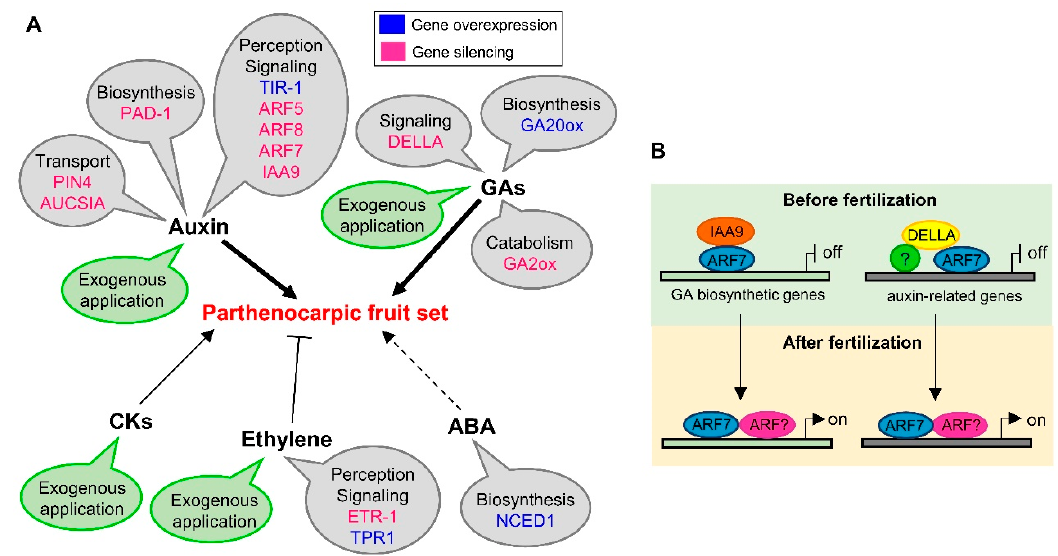
Figure 2. Schematic model of hormonal regulation of parthenocarpic fruit set in tomato ( A ) Parthenocarpy obtained either by exogenous treatments or by genetic manipulations of phytohormones. Gene name in blue means that the gene overexpression leads to parthenocarpy; gene name in pink indicates that the gene silencing causes parthenocarpy. TIR ‐ 1 (TRANSPORT INHIBITOR RESPONSE 1), auxin receptor; ARF5/7/8 (Auxin Response Factor 5/7/8) components of the auxin signaling pathway; PAD ‐ 1 (aminotransferase) implicated in auxin biosynthesis; PIN4 (PIN ‐ formed 4 auxin efflux carrier), component of the auxin transport; AUCSIA (AUxin Cum Silencing Action), probably implicated in the regulation of auxin transport; DELLA, repressors of GA responses; GA20ox (GA 20 oxidase) a GA biosynthetic gene; GA2ox (GA 2 oxidase), a GA catabolic enzyme; NCED (nine ‐ cis ‐ epoxycarotenoid dioxygenase) an ABA biosynthetic gene; ETR ‐ 1 (Ethylene receptor 1), implicated in ethylene perception; TPR1, (tetratricopeptide repeat protein 1), able to bind the ethylene receptor. ( B ) Interplay between auxin and GAs. Before fertilization, the regulatory complex formed by DELLA, an unidentified transcriptional regulator (?), and ARF7, represses the